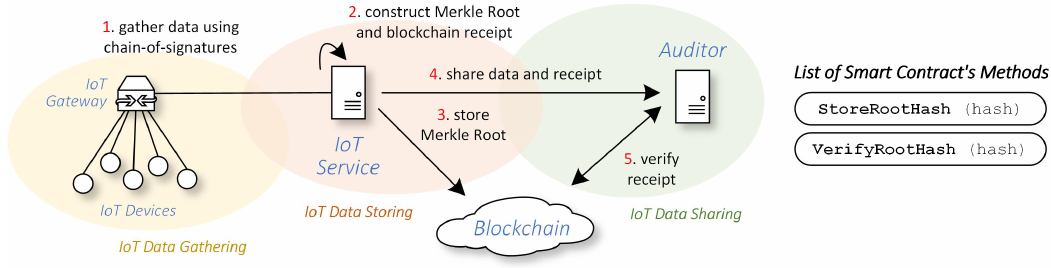
Figure 4. Our blockchain design to protect the integrity of stored IoT data: The protocol starts from gathering IoT data using a chain of signatures, creating Merkle Root and its corresponding blockchain receipts, and then sharing and verifying the receipts. We also depict the required list of smart contract methods for developers to